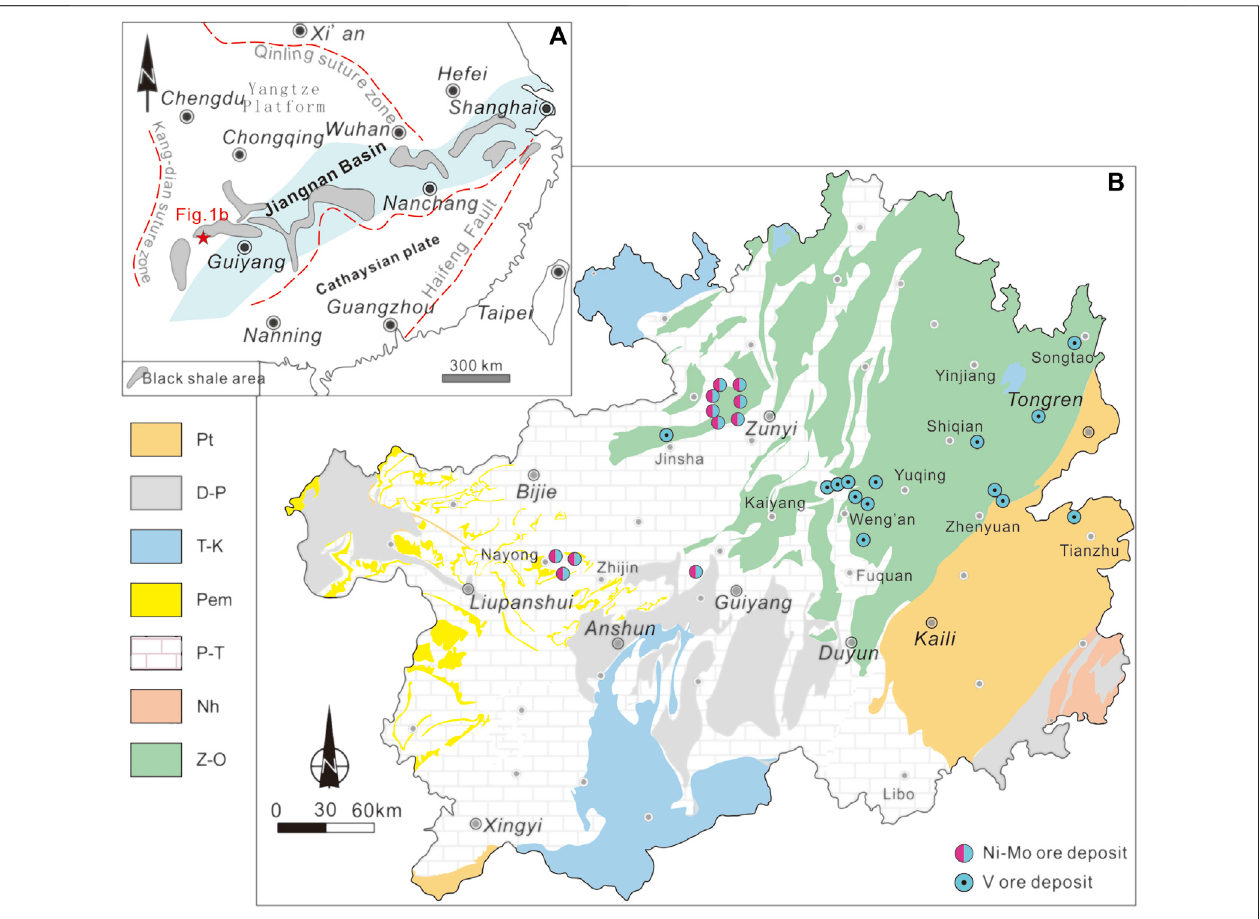
FIGURE 1 | (A) Simpli fi ed paleogeographic map of the Yangtze Platform during the Cambrian (after Mao et al., 2002). (B) Simpli fi ed distribution of black shale polymetallic deposits in Gui Zhou (after Dai et al., 2014).